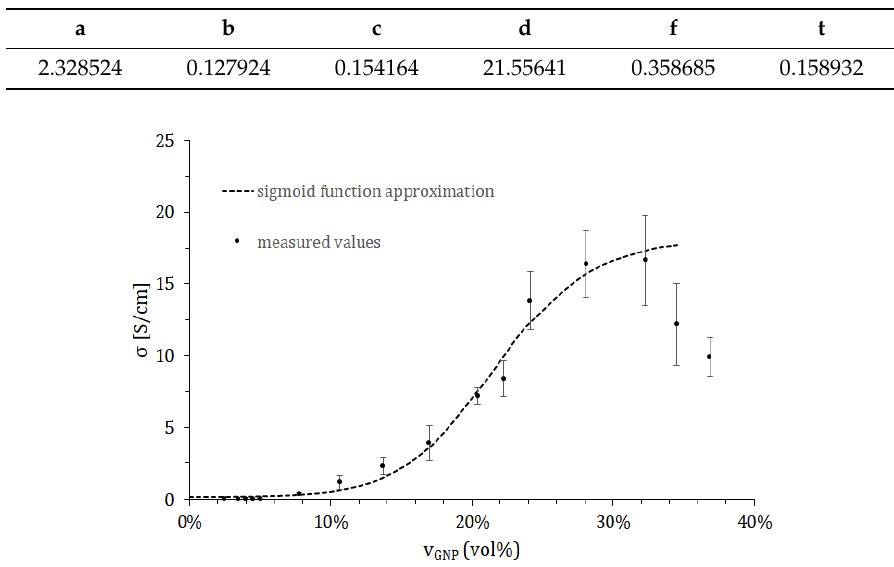
Table 2. Parameters of sigmoid function fitted to experimental conductivity data, parameters corresponding to Equation (3).